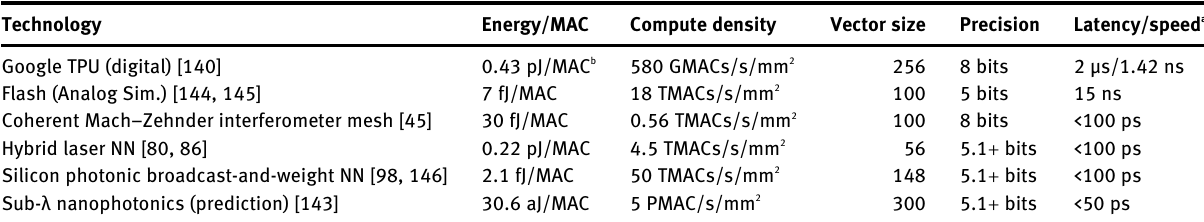
Table  : Comparison of various photonic hardware approaches with a well-known deep learning accelerator during mean operating condi- tions. Adapted from [ 